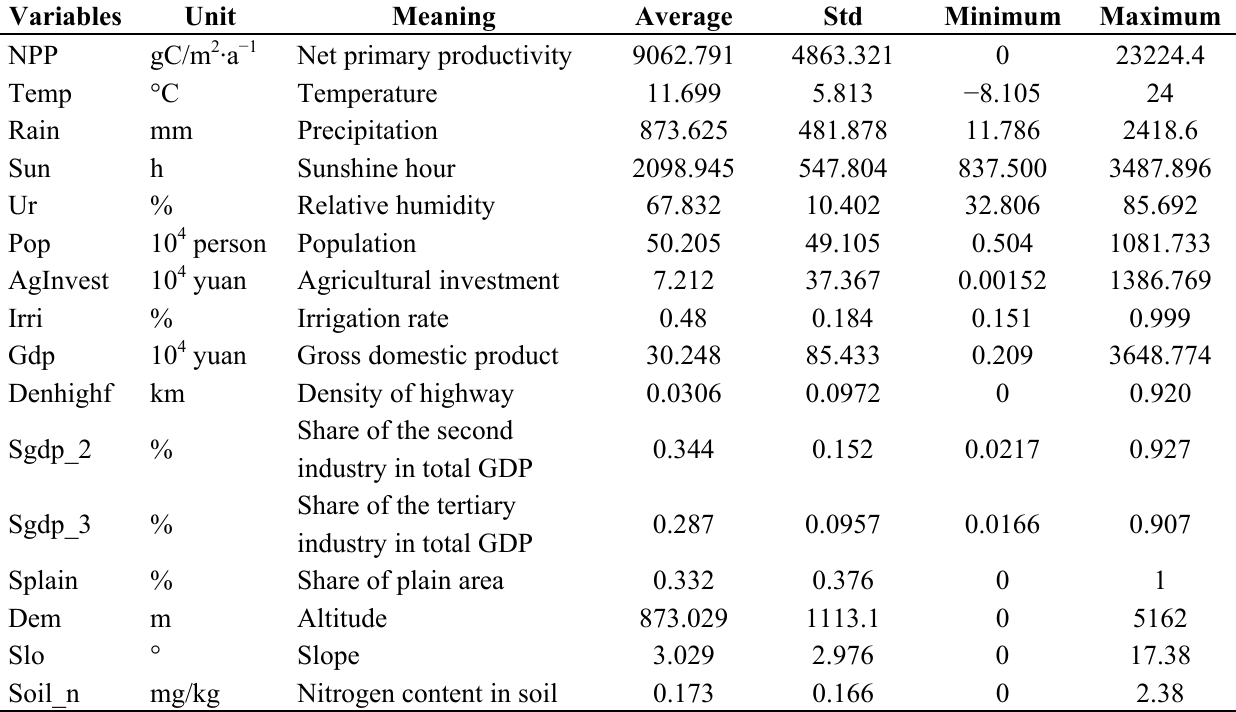
Table 1. Variables for decomposing the causality of carbon bio-sequestration change in